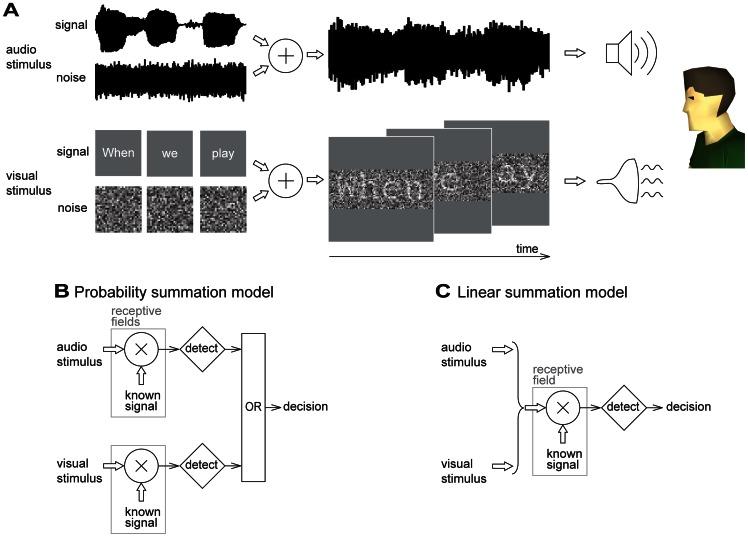

Materials and Methods.(A) A sentence (or a word) is presented as two concurrent streams: text and speech in visual and audio white noise. The observer identifies the words. In Experiments 1, 3, and 4, the visual stream includes only one word. In Experiment 2, the visual stream is a rapid serial visual presentation [35] of a sentence, presented one word at a time. The audio stream presents the same words as the visual stream. (B & C) The critical difference between models B and C is whether the two streams converge before or after detecting the signal. This dichotomy has been called “pre- and post-labelling” in speech recognition [36]. A neural receptive field computes a weighted average of the stimulus, i.e. the cross correlation of the stimulus and the receptive field’s weighting function [37]. In fact, if the noise is white, taking the weighting function to be a known signal, the receptive field is computing the log likelihood ratio of the presence of that signal in the stimulus, relative to zero signal. When the possible signals are equally probable, the best performance is attained by the maximum likelihood choice. (B) In probability summation, there is a receptive field for each possible signal. Detection occurs independently in each stream and the detections are combined logically to yield the overt decision. This is practically optimal when there is uncertainty among the known signals [38]. (C) In linear summation there is just one receptive field. The signals are linearly combined by a single audio-visual receptive field, followed by a single detector, which emits the final decision [22]. This is optimal for a known audiovisual signal.